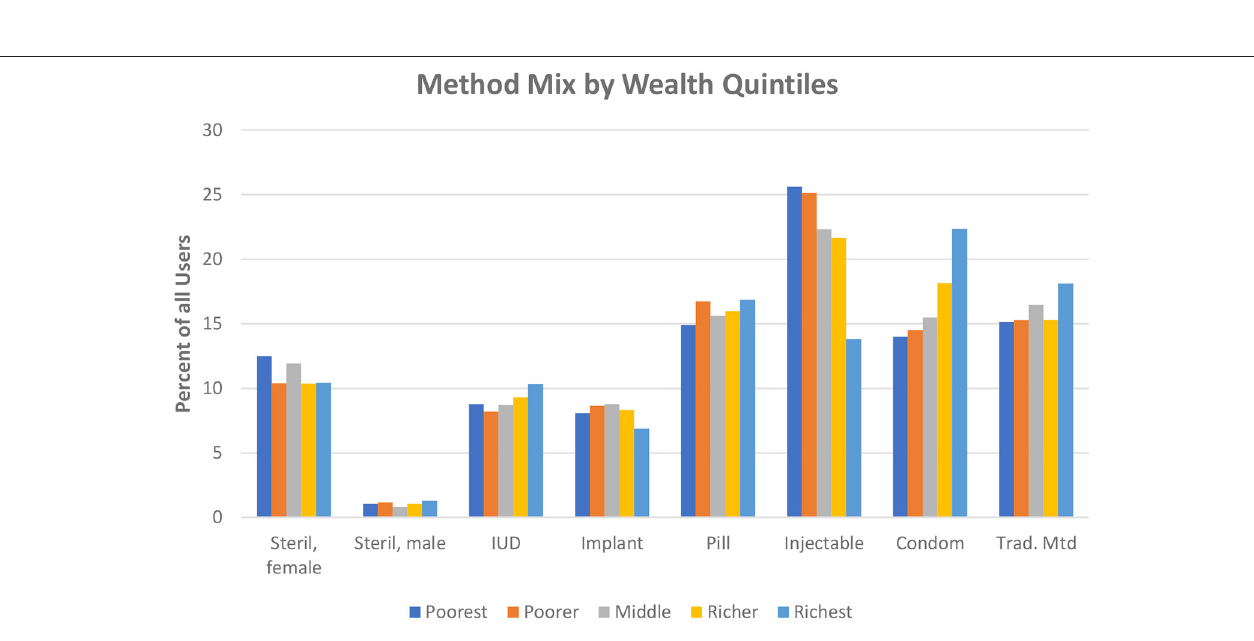
FIGURE 4 | Differentials in the percentage using any method of contraception by four personal characteristics, urban sector.